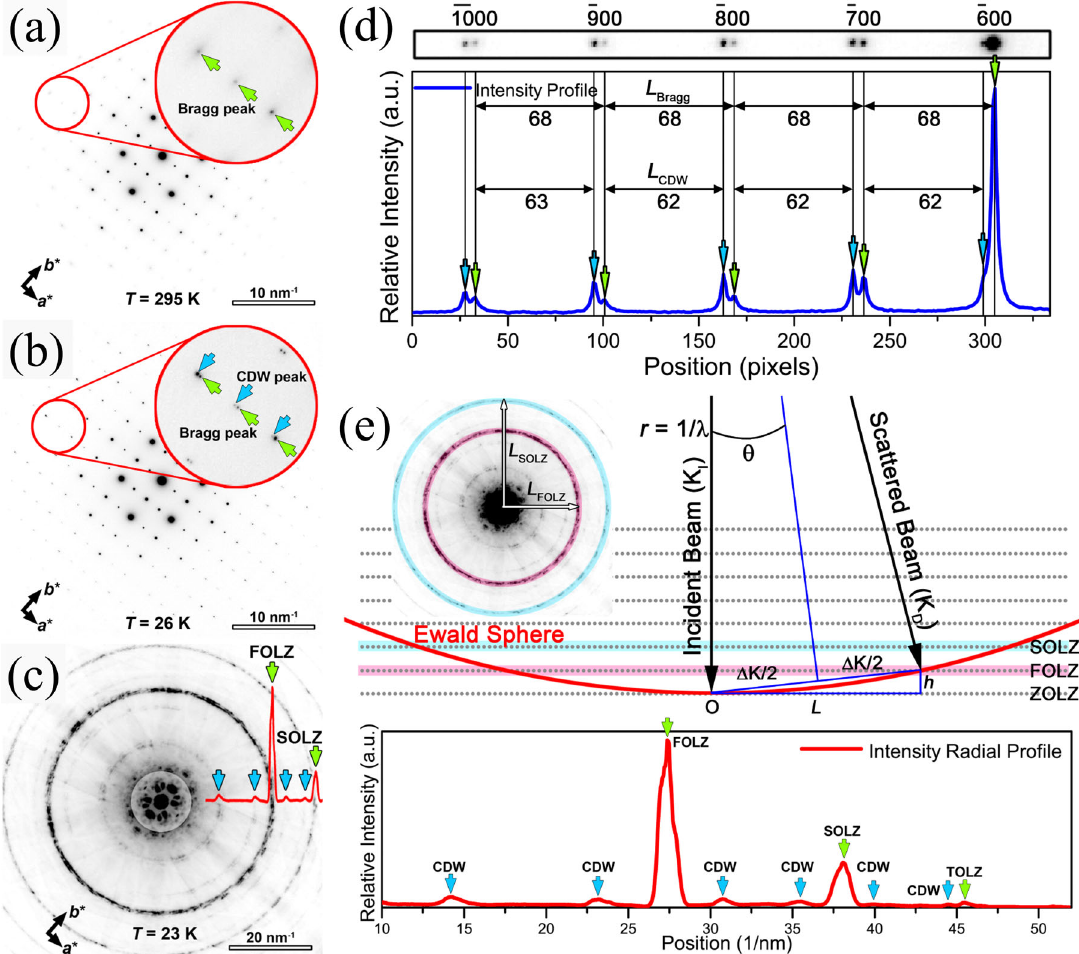
Fig. 2 Electron diffraction patterns of HfTe 3 . Typically selected area electron diffraction (SAED) patterns taken along the [001] zone axis at a 295 K and b 26 K, respectively. The satellite spots (indicated by blue arrows) appear at low temperatures around the Bragg spots (green arrows), indicating the formation of structural modulation. c A convergent beam electron diffraction (CBED) pattern taken along the [001] zone axis, showing extra Laue zones (blue arrows) due to the structural modulation. The radial intensity distribution is plotted as an inset, with the positions of the fi rst/second-order Laue zone (FOLZ/SOLZ) indicated by green arrows. Based on ( b ) and ( c ), the modulation vector can be determined to be q = 0.91(1) a * + 0.27(1) c *. d Intensity line pro fi le from spot ð 600 Þ to ð 1000 Þ extracted from the SAED pattern ( b ). The intervals between different spots are labeled. e Upper panel: the geometric con fi guration showing the Ewald sphere intercepts points in the Laue zones. Lower panel: the intensity radial pro fi le extracted from CBED pattern ( c ), from which the L values can be electron energy is 200 keV). The L values for different rings indicating that the structural modulation vector q has both a * and c * components, i.e., q = q a * + q c *. The extra Laue zones can be obtained from the radial pro fi le plotted in the low panel of a c Fig. 2e. Then, by calculating h for different Laue zones and the (indicated by blue arrows) presented in the [001] CBED pattern, ratios (for example q c = h CDW / h FOLZ , where h CDW and h FOLZ are Fig. 2c, further con fi rm that the modulation vector does not lie in the h values for the innermost ring and the FOLZ ring, the ab plane. respectively), q c is estimated to be 0.27(1). Thus, we can write In order to determine the value of q a and q c , the intensity q = 0.91(1) a * + 0.27(1) c *. distributions of CDW spots/rings in Fig. 2b, c are summarized in To further understand the temperature-dependent behavior of Fig. 2d, e, respectively. Figure 2d shows the line intensity pro fi le the structural modulation, we acquired SAED patterns at several from spot ð 600 Þ to ð 1000 Þ , in which the intervals between different temperatures, as shown in Supplementary Fig. 2. It is adjacent Bragg spots ( L Bragg ) and the distance from one Bragg evident that the superlattice spots (indicated by blue arrows) spot to the next-nearest CDW neighbor ( L CDW ) are labeled. Using become dim at 81 K and totally disappear at 88 K, showing good q a = L CDW / L Bragg , q a is calculated to be 0.91(1). On the other hand, agreement with the CDW phase transition temperature deter- the value of q c can be estimated with the aid of the geometric mined from the resistivity measurements. The result suggests that con fi guration presented in Fig. 2e. The positions of the rings in the superlattice spots observed in diffraction patterns are directly Fig. 2c are directly related to the interception of the Ewald sphere related to the formation of the CDW phase. with the Laue zone layers. For high-energy electrons, we can write It is worth noting that the satellite spots appeared in the ¼ h an expression for the angle θ in Fig. 2e: sin θ ¼ Δ K = 2 ffiffiffiffiffiffiffiffiffiffiffiffiffiffi p electron diffraction patterns of ZrTe 3 at room temperature. Δ K . Using the r r 2 (cid:2) L 2 equation ð Δ K Þ 2 ¼ h 2 þ L 2 , we have h ¼ r (cid:2) , where r is Eaglesham et al. 6 believed that the satellite spots at room temperature indicated the composition modulation of ZrTe 3 the radius of the Ewald sphere ( r = 398.74 nm − 1 when the